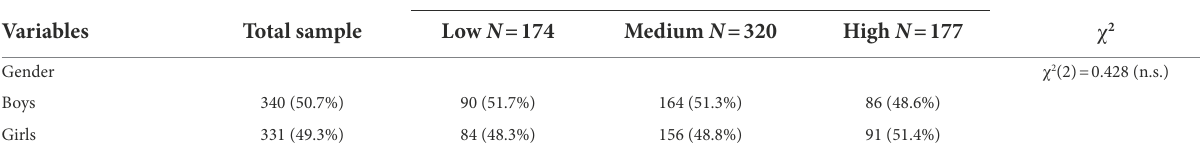
TABLE 1 Sociodemographic